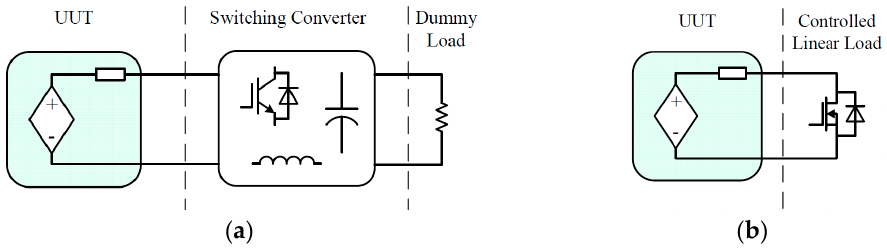
Figure 1. Electronic load types ( a ) switching e-load ( b ) linear e-load